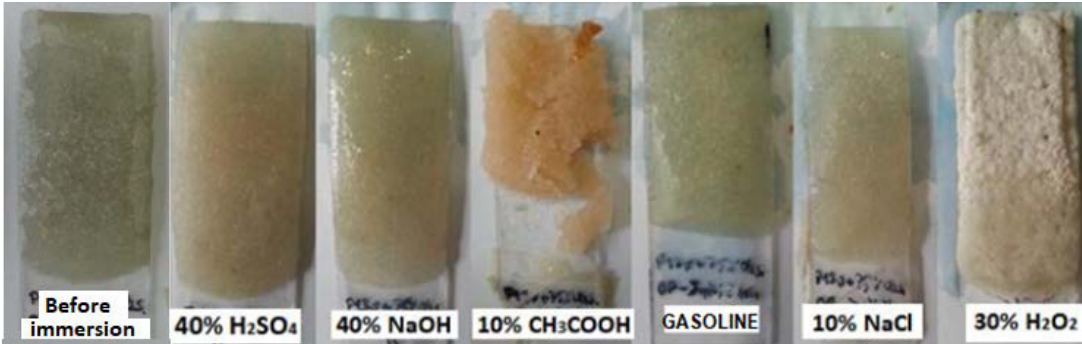
Figure 13. Samples of epoxy composites composed of the waste glass (WGS) and the ER1 polymeric matrix after 28 days of exposure to various chemically aggressive environments.